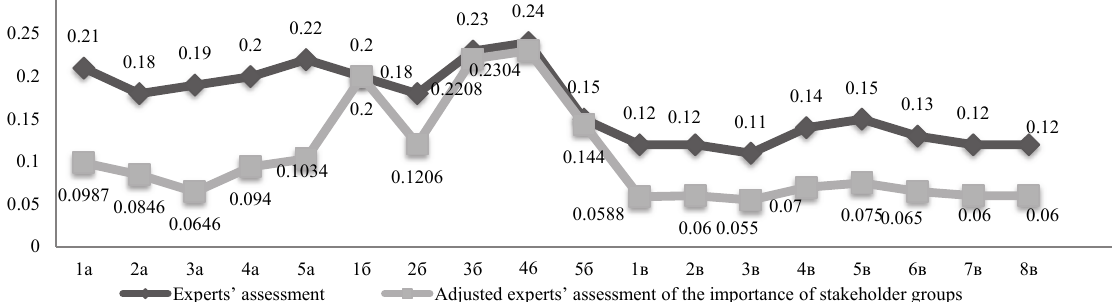
Fig. 2. Evaluation of the stakeholders’ priority interests Expert № 1 preferences of the main components of the studied enterprise efficiency by the priority level Compared options